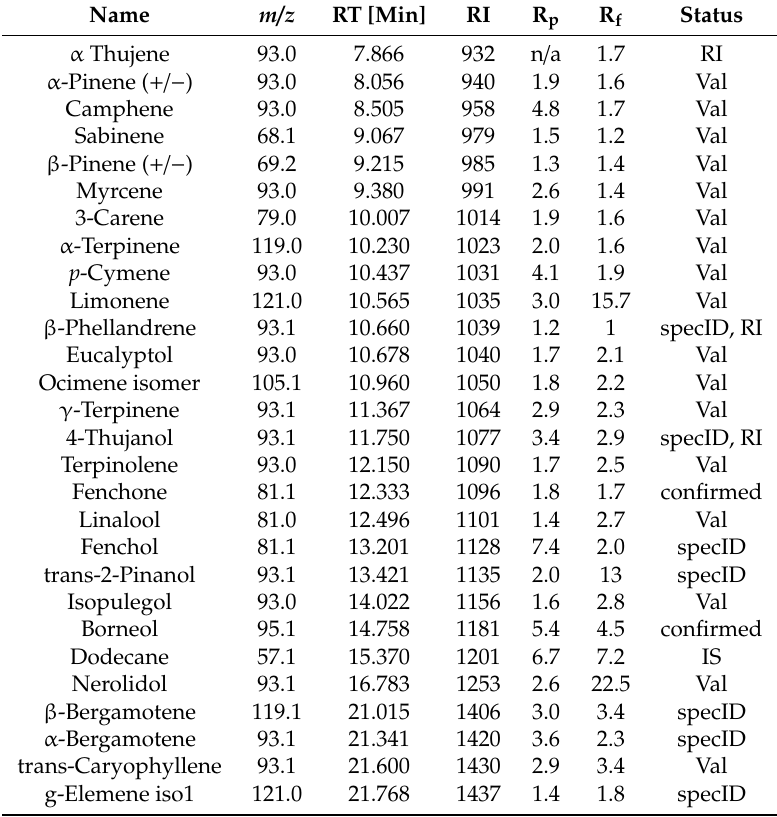
Table 1. Compounds detected in this study, their base peak (quantifier) ions ( m / z ), retention times (RT) and indices (RI), resolution to the closest preceding (R p ) and following peaks (R f ), and identification status (specID: based on library match; RI: based and library match and retention time index; confirmed: matches spectrum and RT of authentic standard; Val: confirmed compound used for method